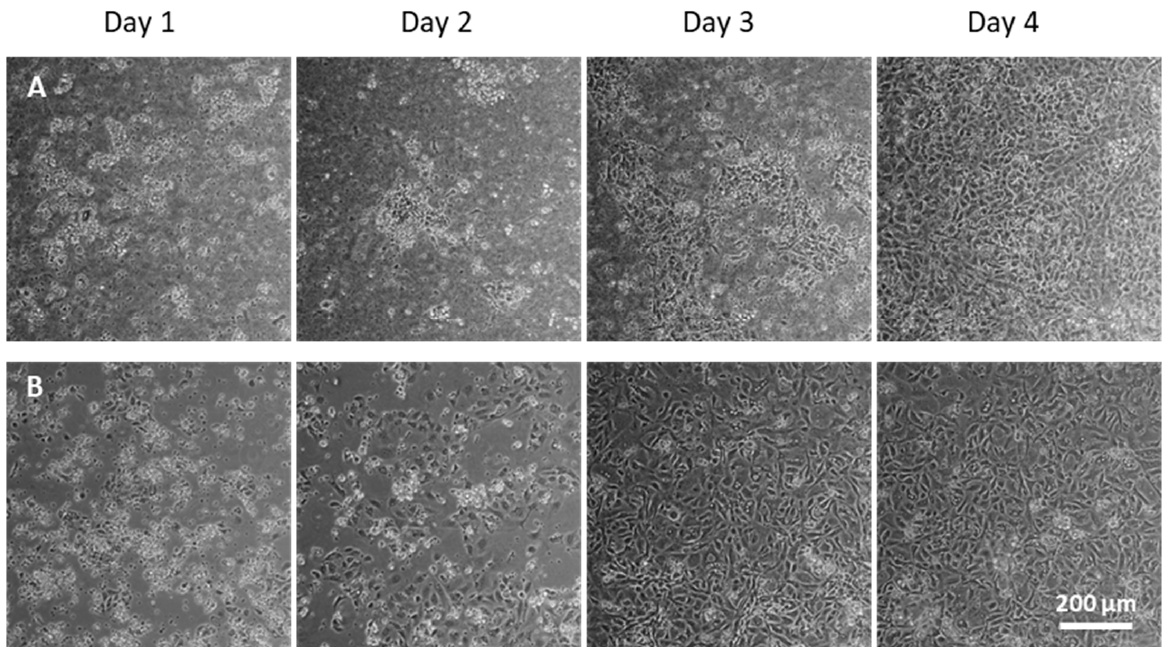
Figure 1. Rat primary alveolar cells were cultured either on porcine lung-derived hydrogel ( A ) or on a plate ( B ). Bright field images were taken every 24 h from day 1.